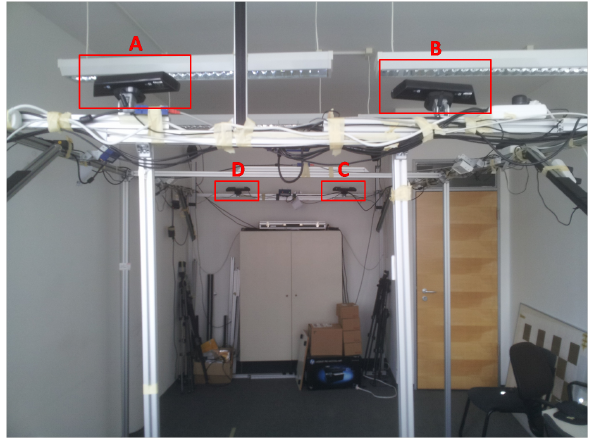
Figure 2: Aluminium construction with mounted Kinects sensors